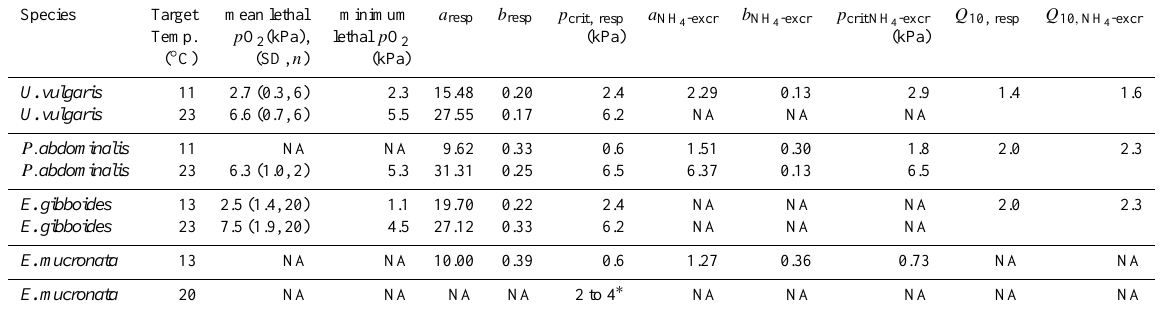
Table 3. Lethal p O 2 , parameter estimates ( a , b ) of fitted power functions, p crit and Q 10 values for respiration and excretion rate data.